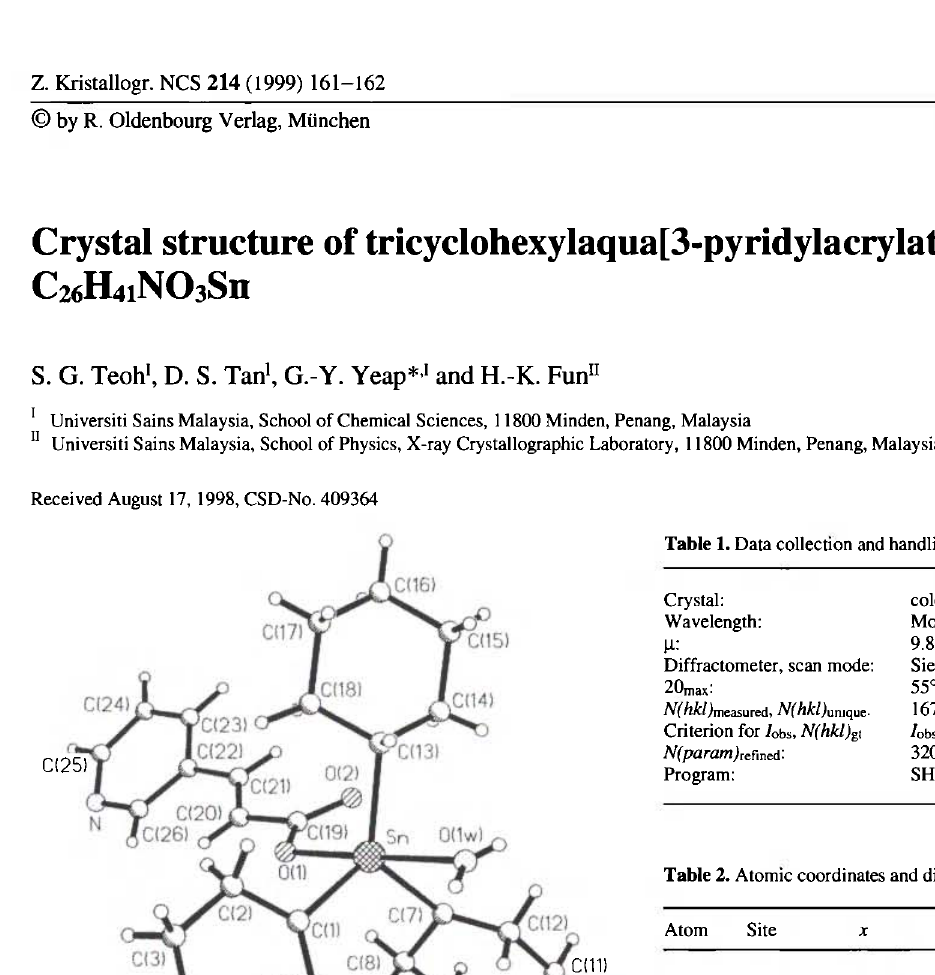
Table 2. Atomic coordinates and displacement parameters (in A